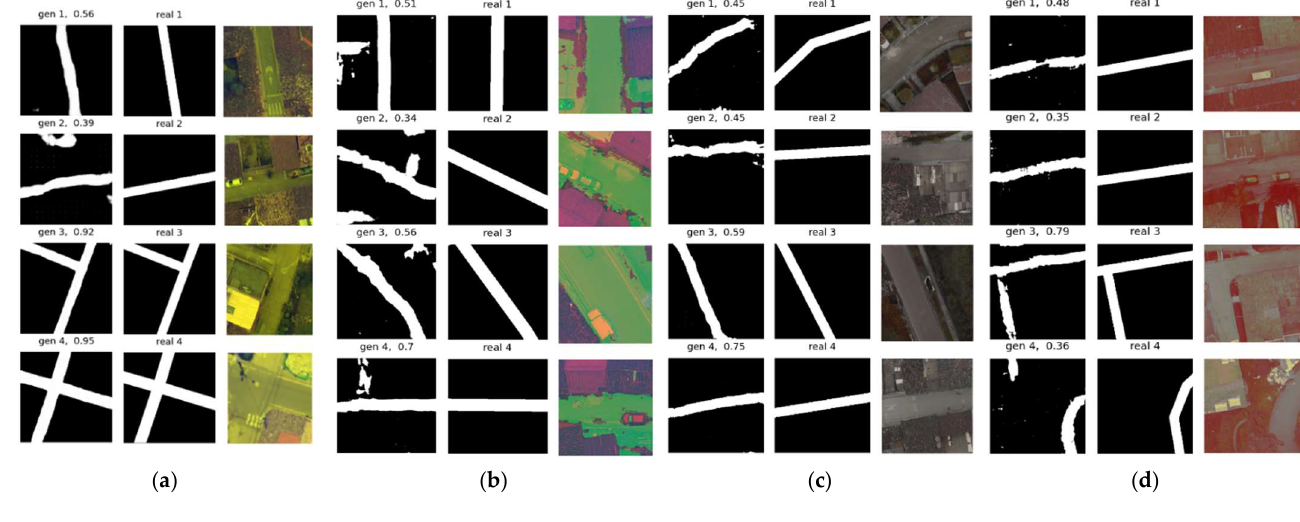
Figure 11. ( a ) RGDSM, ( b ) RVARIB, ( c ) HRGB, ( d ) HRVARIB. Table 2. Road dataset performance using data fusion. Table 2. Road dataset performance using data